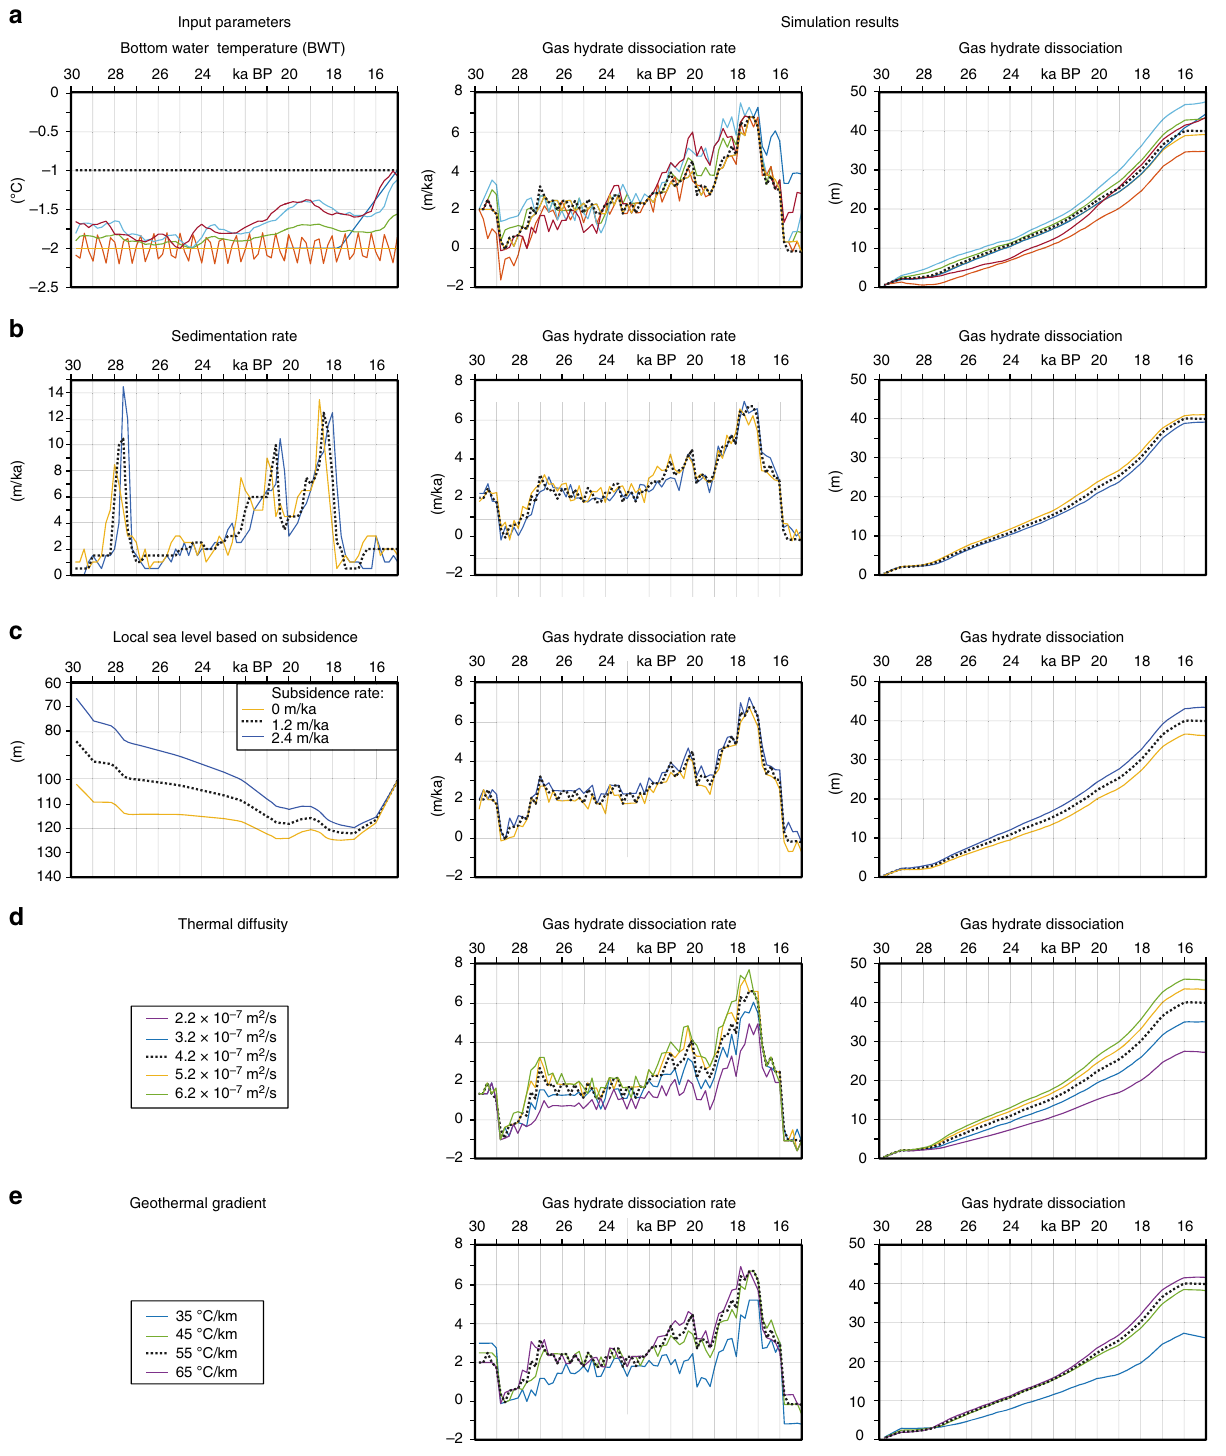
Fig. 8 Results of the sensitivity analyses for different simulation input parameters. a Bottom water temperature pro fi les and the resulting gas hydrate dissociation rates and absolute gas hydrate dissociation curves. b Sedimentation rates: minimum, maximum and best- fi t sedimentation rate reconstructions and the resulting gas hydrate dissociation rates and absolute gas hydrate dissociation curves. c Subsidence rate as well as their impact on the local sea level anomaly and the resulting gas hydrate dissociation rates and absolute gas hydrate dissociation curves. d Thermal diffusivity and the resulting gas hydrate dissociation rates and absolute gas hydrate dissociation curves. e Geothermal gradient and the resulting gas hydrate dissociation rates and absolute gas hydrate dissociation curves